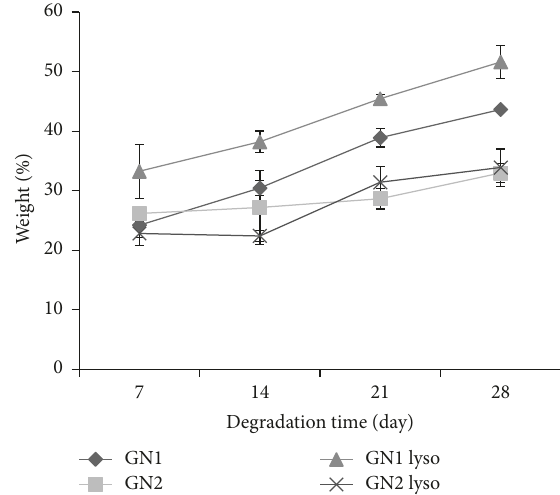
Figure 2: In vitro degradation of the genipin-CS scaffolds exposed to PBS and to the hydrolytic